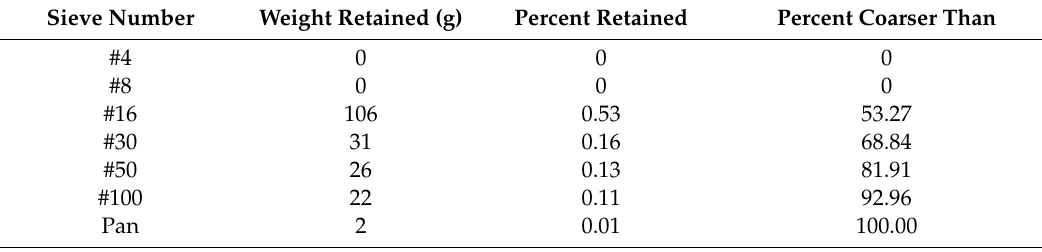
Table 2. Sieve analysis test results of the perlite